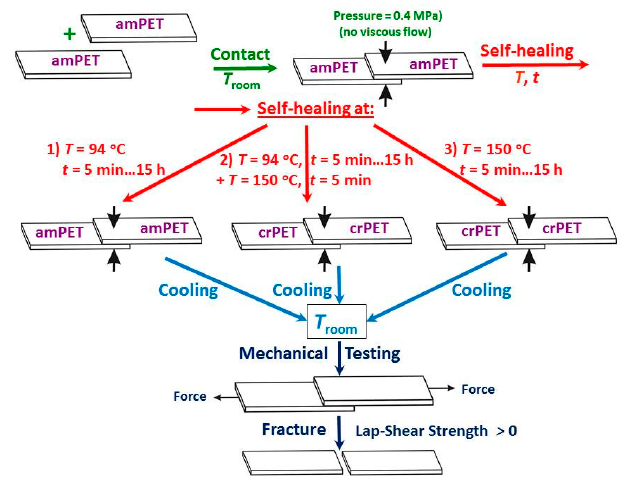
Figure 1. Schematic representation of the experimental procedures used in this work.